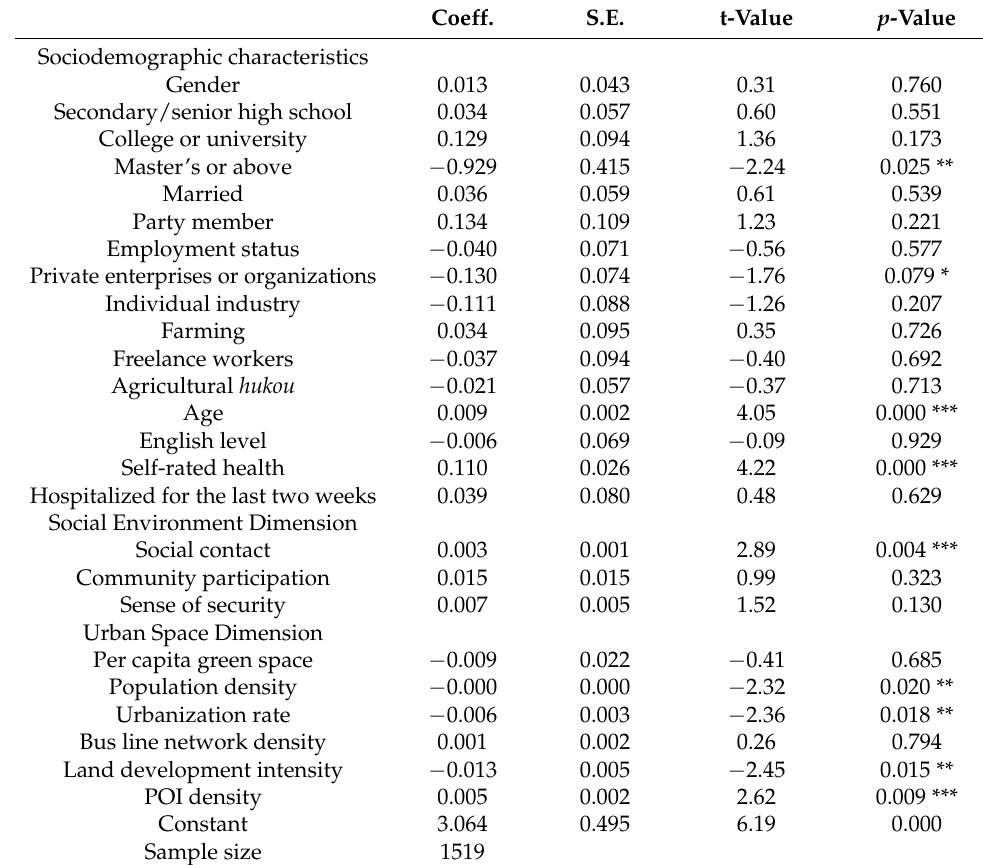
Table 3. Regression results for social trust in the entire sample.